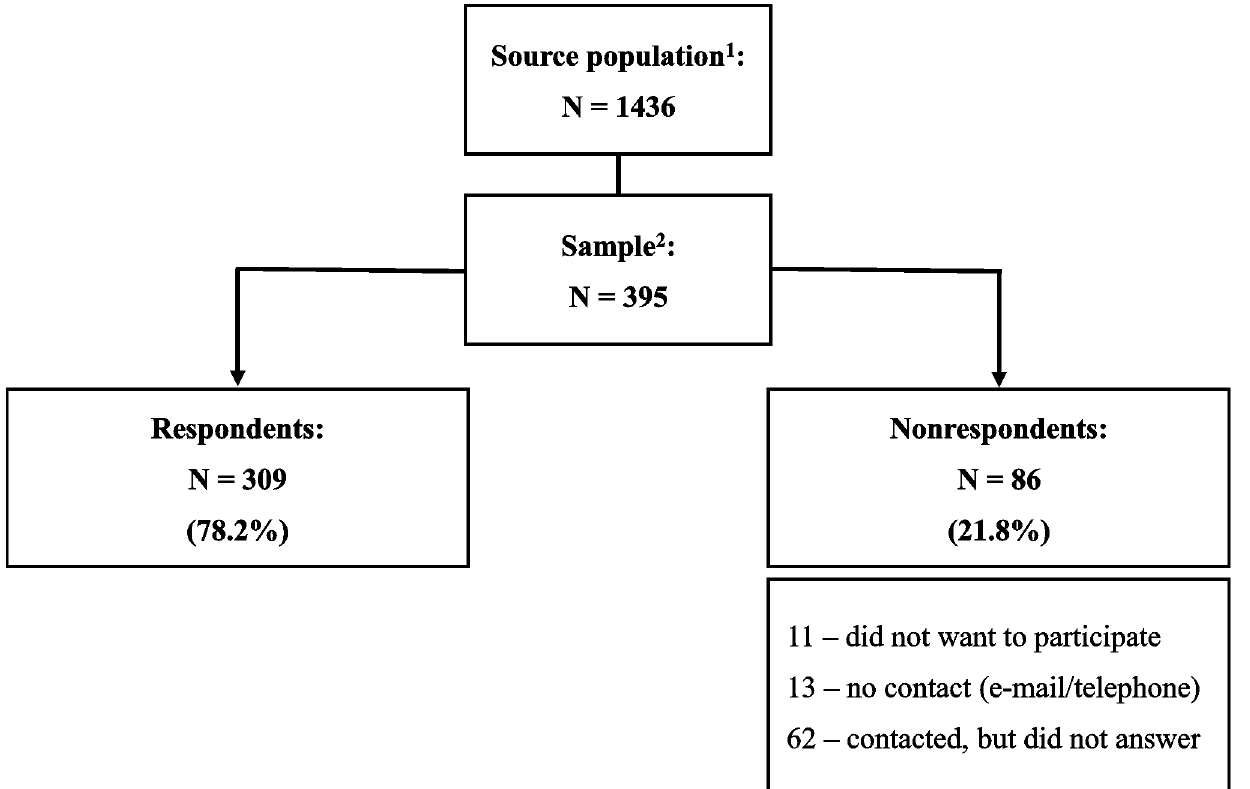
Fig 1. Flow diagram of participants ’ selection. 1: Practicing rheumatologists, members of the Brazilian Society of Rheumatology; 2: Random sample, stratified proportionally to the number of rheumatologists in each Brazilian geographic region.